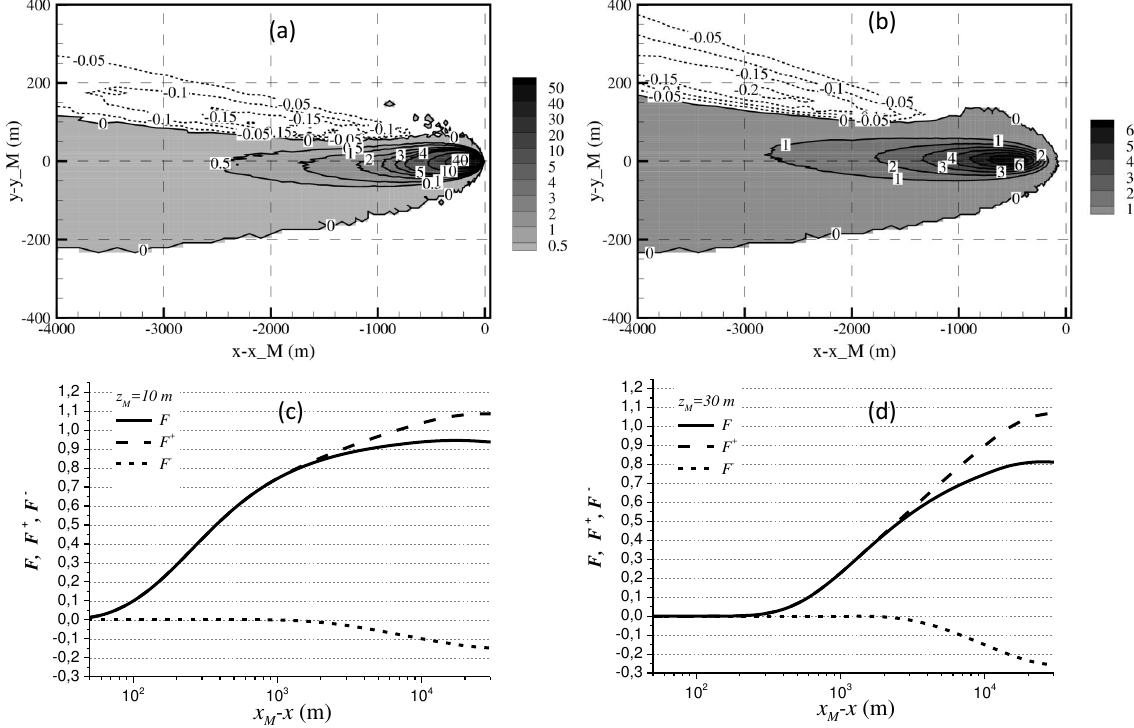
Figure 8. Two-dimensional footprints f s (x − x M ,y − y M ,z M ) ( × 10 − 6 m − 2 ) for sensor height z M = 10m (a) and z M = 30m (b) and the corresponding crosswind-integrated cumulative footprints F(x M − x) (c) and (d) ; long dashed line – F + (impact of the area with positive values of f s ); short dashed line – F − (impact of area with negative